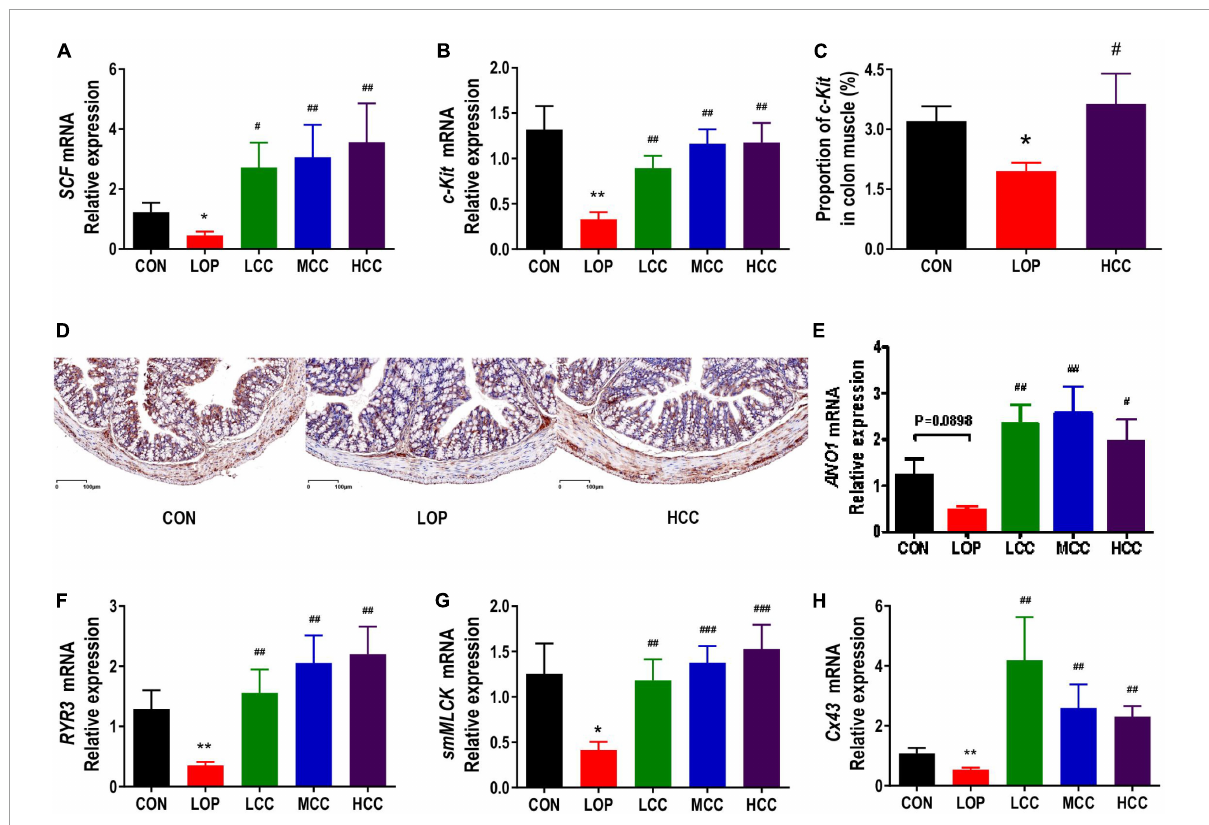
FIGURE3 Aqueous extract of Cymbopogon citratus (DC.) Stapf (CCAE) increased the expression of gastrointestinal motility factors in the colon of STC mice. (A,B) The mRNA expression of stem cell factor ( SCF ) and stem cell factor receptor ( c-Kit ) in the colon. (C) Percentage of c-Kit-positive area in colon muscle. (D) Representative immunostaining images of colon sections stained for c-Kit. (E–H) The mRNA expression of Anoctamin 1 ( Ano1 ), Ryanodine receptor 3 ( RyR3 ), smooth muscle myosin light chain kinase ( smMLCK ), and Connexin 43 ( Cx43 ) in the colon. The data are expressed as the means ± SEMs ( n = 8). *, Compared with the CON group; #, compared with the LOP group. * P < 0.05, ** P < 0.01, *** P < 0.001. # P < 0.05, ## P < 0.01, ### P <